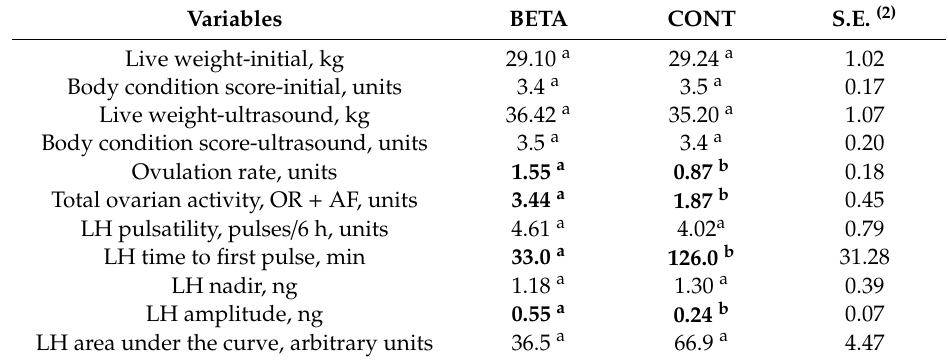
Table 2. Least square means regarding live weight and body condition score at the onset of treatments (live weight (LW)-initial, kg and body condition score (BCS)-initial, units) and at the ultrasound scanning (LW-ultrasound, kg and BCS-ultrasound, units), ovulation rate (OR, units), total ovarian activity (TOA = OR + antral follicles, AF), and luteinizing hormone (LH) profile across time (pulsatility, time to first pulse, amplitude, nadir, and area under the curve) in cross-bred (Alpine–Saanen–Nubian × Criollo; n = 22) yearling goats supplemented with betacarotene (BETA) and non-supplemented (CONT) during the anestrous season (April–May) under semiarid conditions in Northern Mexico (26 ◦ N) (1)